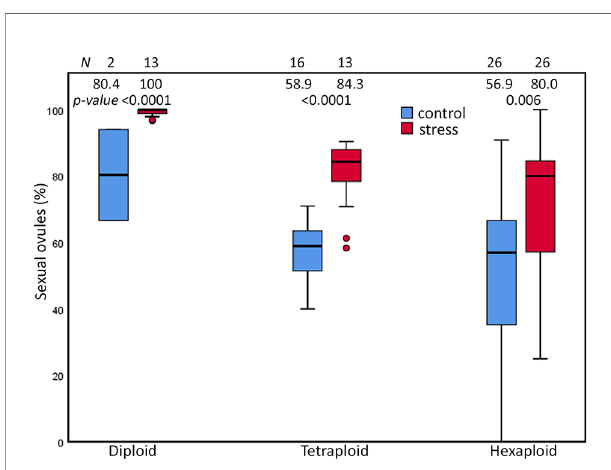
FIGURE 2 | Proportions of sexual ovules in the R. auricomus complex plants grown in climatic chamber under prolonged photoperiod (stress) and shortened photoperiod (control). Mean values and statistical signi fi cance are given in fi gure. N = number of individuals. For the test statistics, see Supplementary Table 2